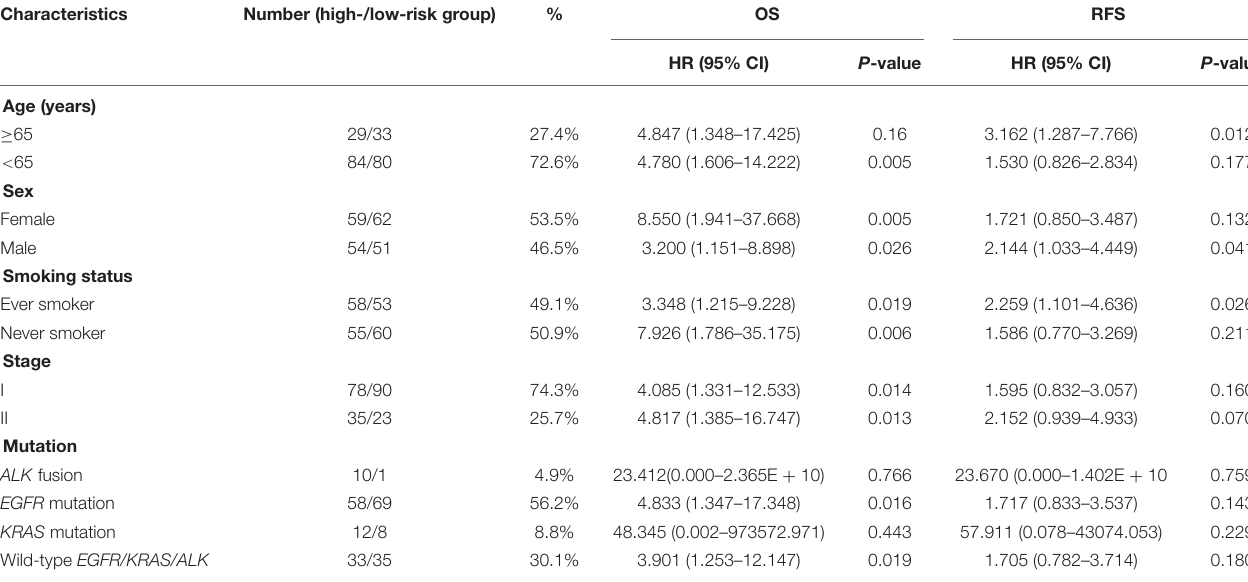
TABLE 2 | Prognostic roles of the ARGs signature with different demographic and clinical characteristics in GSE31210 validation set. Characteristics